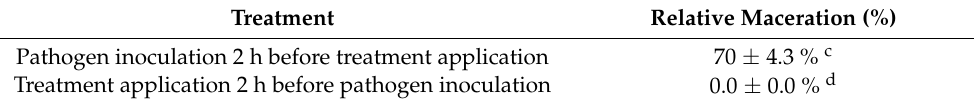
Table 4. Cont. Treatment Relative Maceration (%) Pathogen inoculation 2 h before treatment